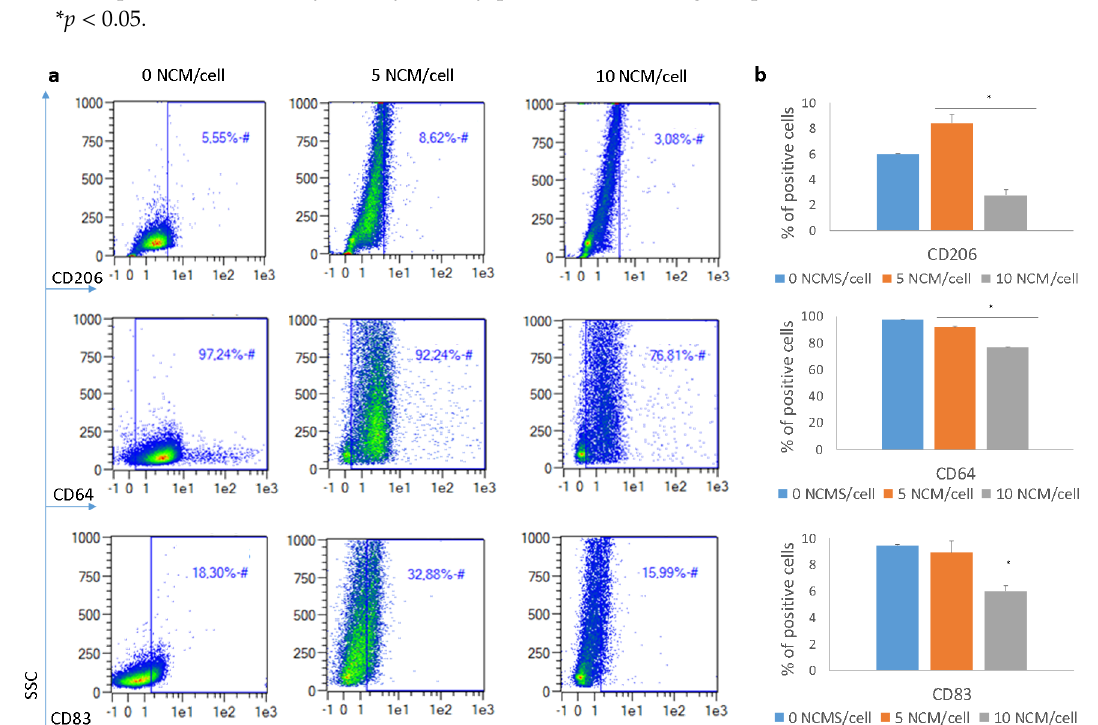
Figure 6. Surface marker changes when M1 macrophages were incubated with 5 and 10 NCM/cell. ( a ) Representative flow cytometry density plots. ( b ) Percentage of positive cells for each marker. * p < 0.05.